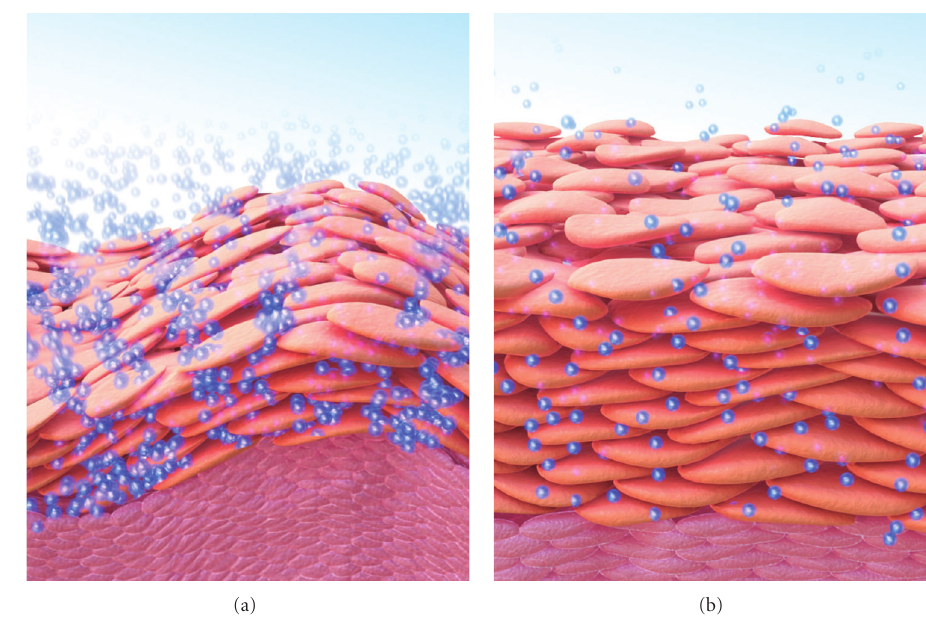
Figure 1: Infant and adult skin: stratum corneum (SC) hydration and water transport properties. The SC of infant skin (a) and adult skin (b) is hydrated (small blue spheres) under normal conditions. Infant SC is more hydrated but also loses water at higher rates than adult SC